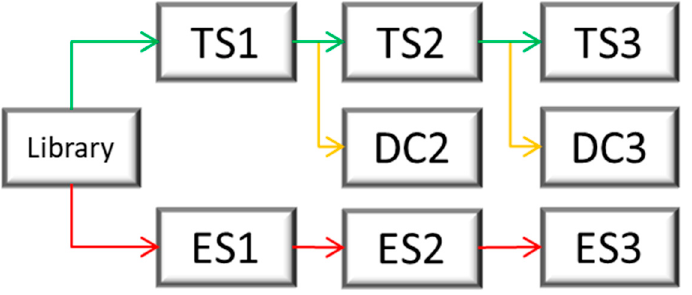
Figure 14. Schematic overview of the selection course. Two selections were started in parallel, the target selection 1 (TS1) and the empty selection 1 (ES1). All target selections had the D-tau(271-316) immobilized on the plate surface during selection (green arrow). All empty selections were devoid of the D-tau(271-316) immobilized on the plate surface during selection and were used as negative controls (red arrow). Direct controls (DC2 and DC3) were used as another form of negative control (yellow arrow). Enriched phages of the last target selection round were put onto plates where no D-tau(271-316) had been immobilized and a normal selection round was performed. Negative control sequences were compared with target selection sequences after NGS sequencing to value which peptides were not target-specific.